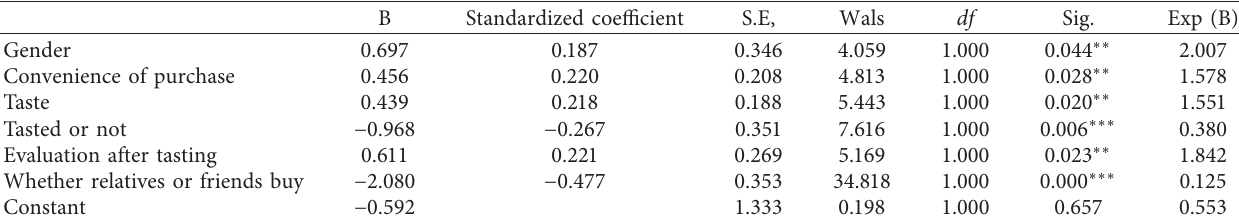
Table 10: Binary logistic analysis of the factors influencing the behavior of purchasing enterprise brand fruits. B Standardized